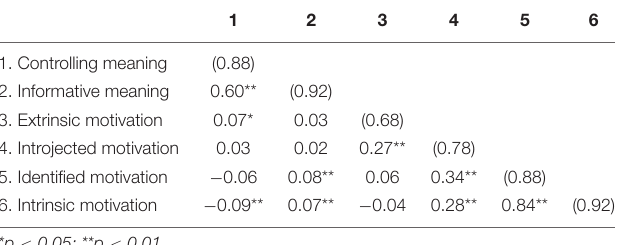
TABLE 3 | Confirmatory factorial analyses for the three samples. ITEMS